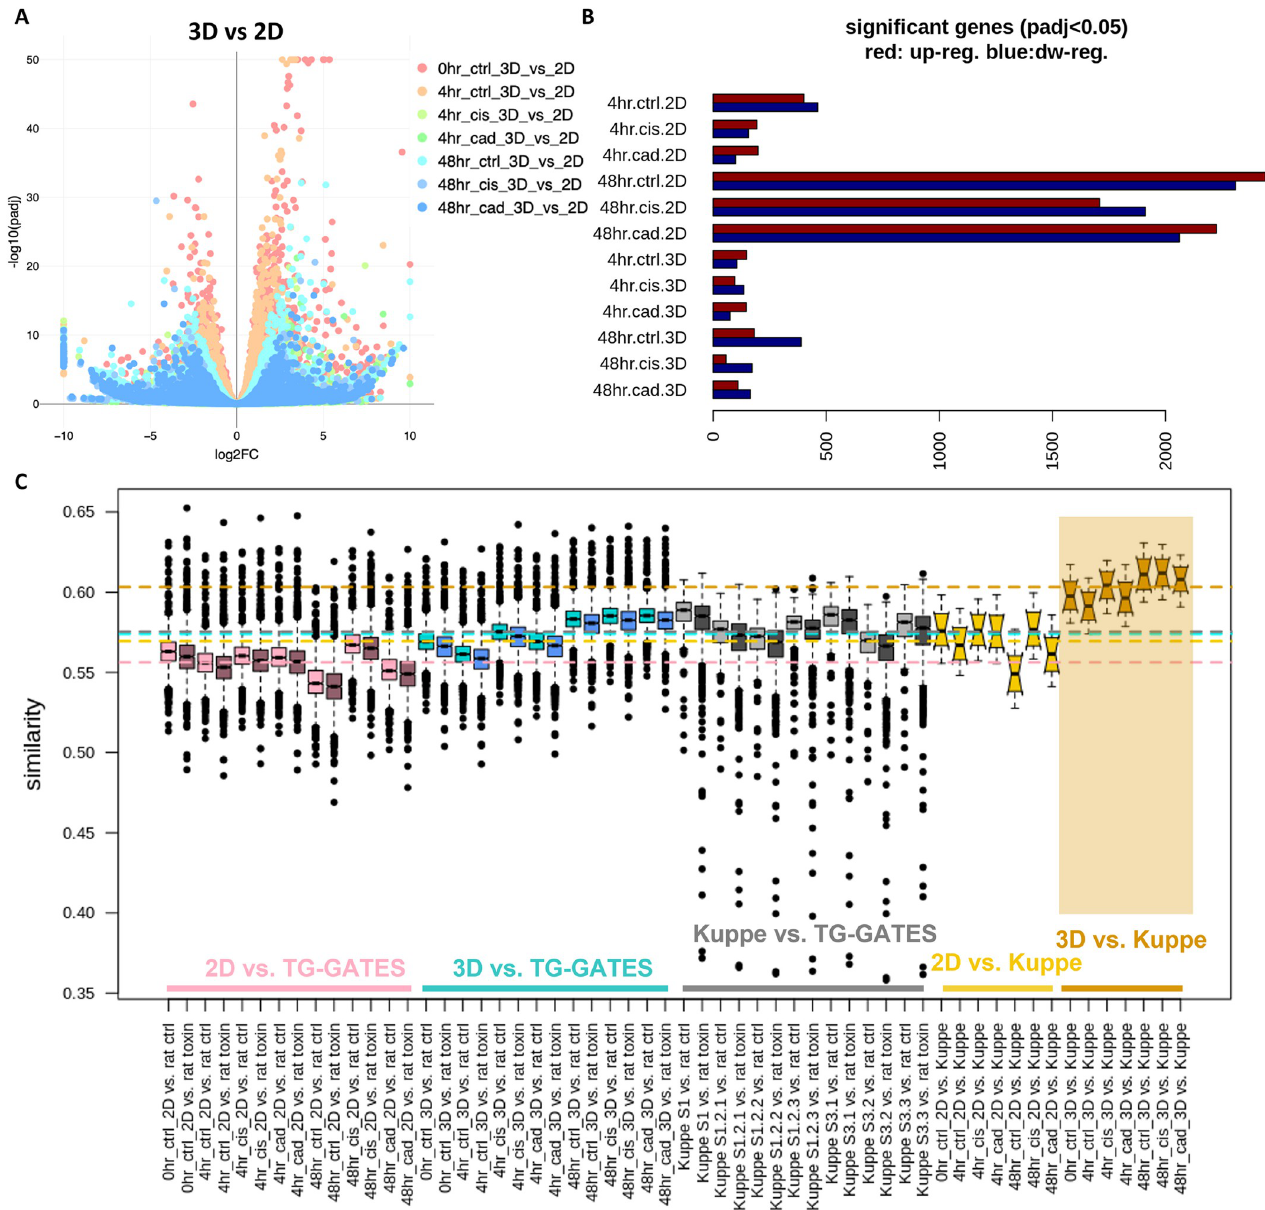
Fig 4. 3D tubuloids demonstrate higher similarity to human kidney tissue than 2D monolayer via RNASeq. (A) Visualization of the RNASeq dataset separated by 3D vs 2D for all samples: Gene changes in 3D model against 2D model are shown; |log2FC| higher than 10 is set to 10 and -log10(padj) higher than 50 is set to 50. (B) Number of differentially expressed genes (padj < 0.05) against the base line (0hr) are shown; red bar: Up-regulated genes, blue bar: Down-regulated genes. (C) Comparison of the expression profiles: Expression profiles of 2D and 3D models, proximal tubules subtypes from human kidney scRNAseq (Kuppe et al.; subtypes: S1, S1.2.1, S1.2.2, S1.2.3, S3.1, S3.2, S3.3), and rats from the TG-GATES data set are compared. Compound treated and un- treated profiles are separated in the comparison and similarity score is the Spearman correlation of expression levels. Box plots are showing distribution of comparison of one profile from one data set against one profile from the other data set; notches indicate 95% confidence interval; the average of each dataset is represented by a dashed, colored line. Rat genes are converted to human genes and common genes in two sets are compared in the analysis. The highest similarity of any dataset was the 3D RNASeq to Kuppe. This indicates that the 3D dataset may be more closely relevant to human kidney tissue than 2D.